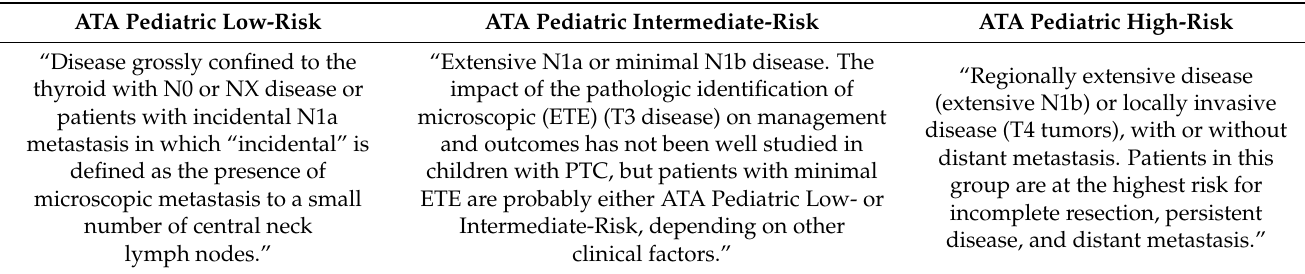
Table 1. ATA pediatric group risk